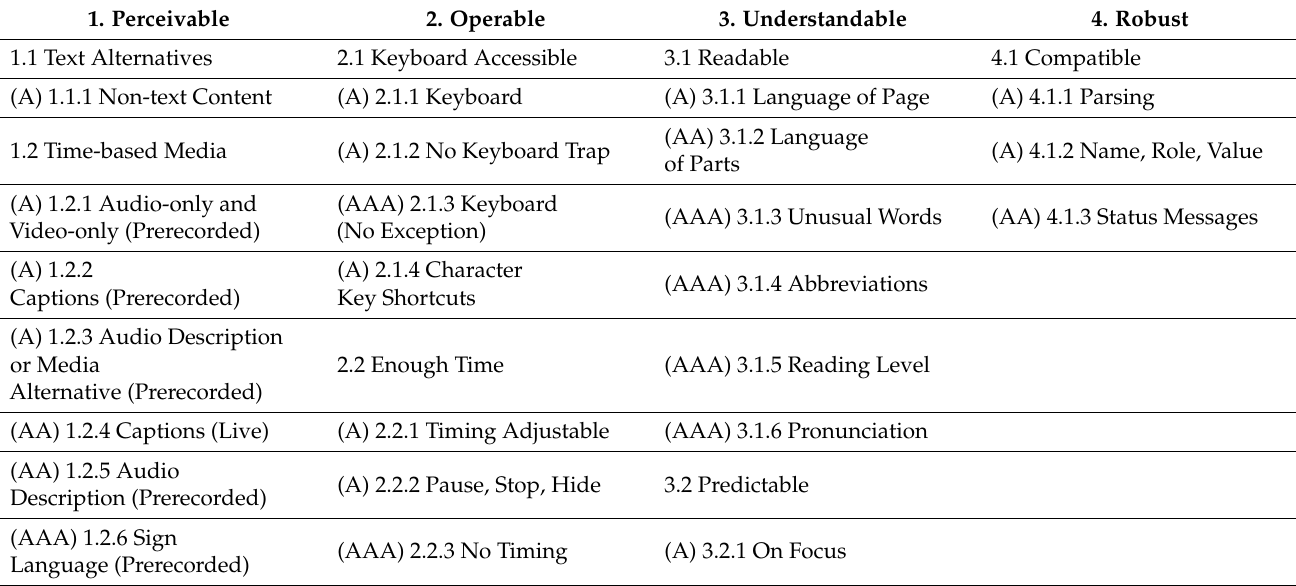
Table 2. WCAG design principles, guidelines, and success